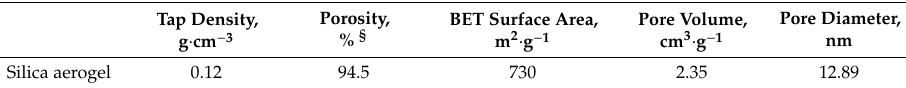
Table 1. Some physical properties of the starting silica aerogel powder.